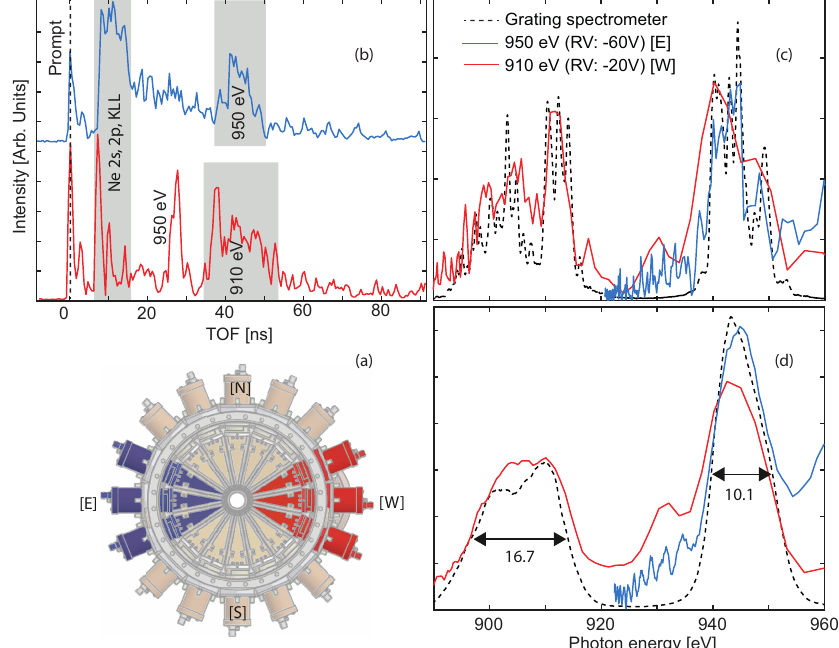
Figure A4. ( a ) 16 eTOF drift-tubes oriented perpendicularly with respect to the X-ray beam. The retardation voltages can be set individually for different subsets of eTOFs to optimize the resolution for different photon energies. ( b ) Single pulse TOF spectrum registered at detectors [E] and [W] with U1 tuned to 950 eV and U2 tuned to 910 eV respectively. ( c ) Spectra converted to photon-energy. This data set was collected in single-bunch mode which enables us to compare the spectra with the grating spectrometer for both colors. ( d ) The average intensity of 500 consecutive pulses which represents the XFEL